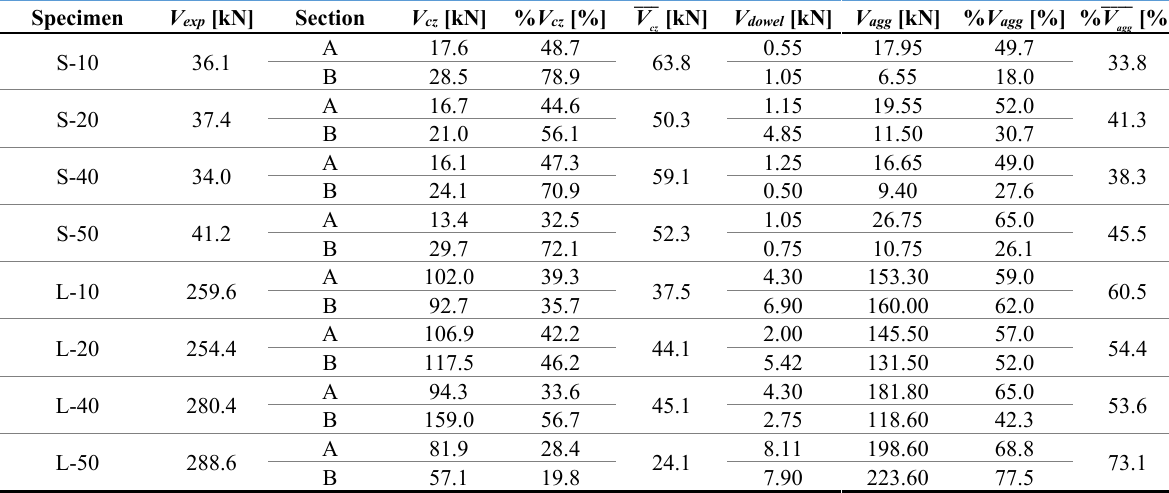
Table 5. Plots of shear force obtained by numerical analysis of each of the internal mechanisms of resistant concrete.